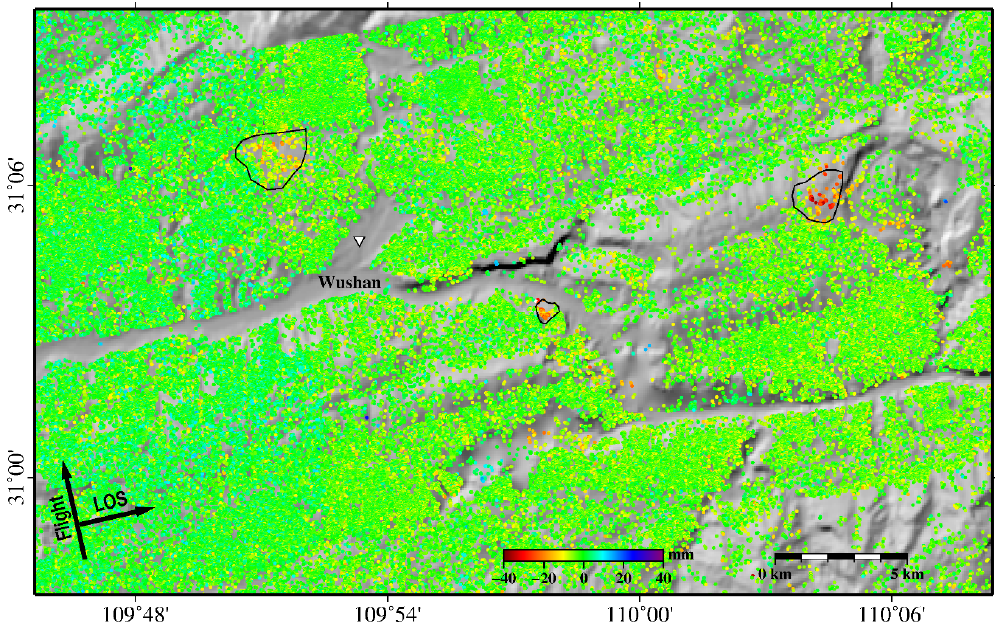
Figure 6. Mean displacement rate map of Wushan.